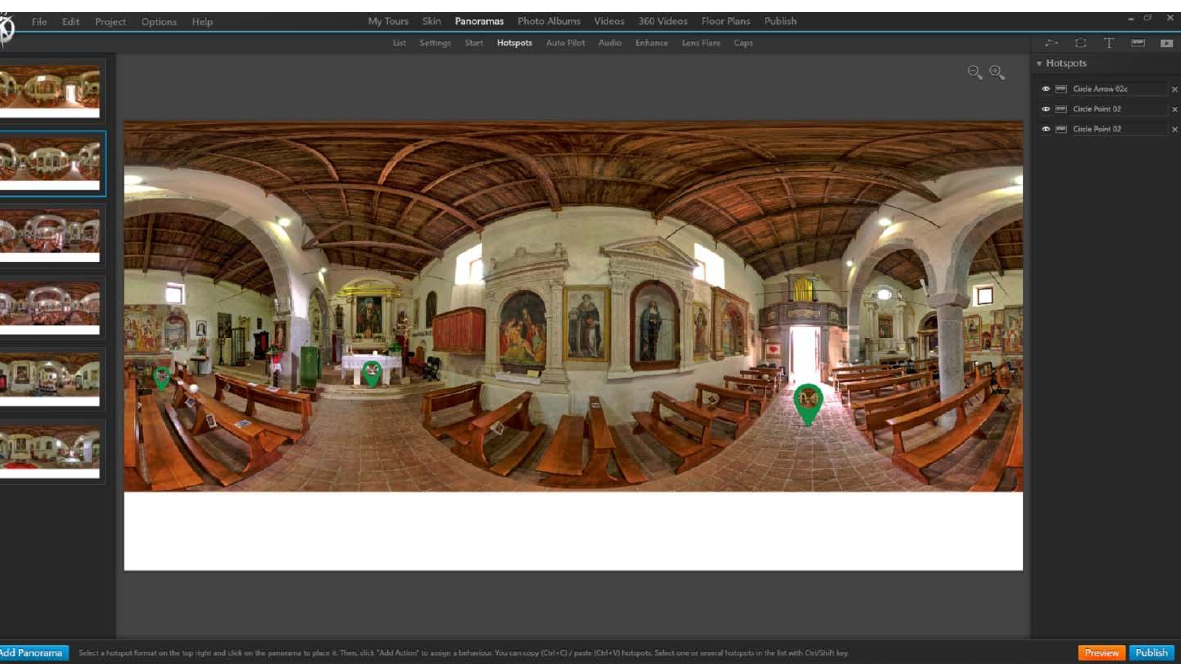
Figure 6. Screenshot of 3DVista